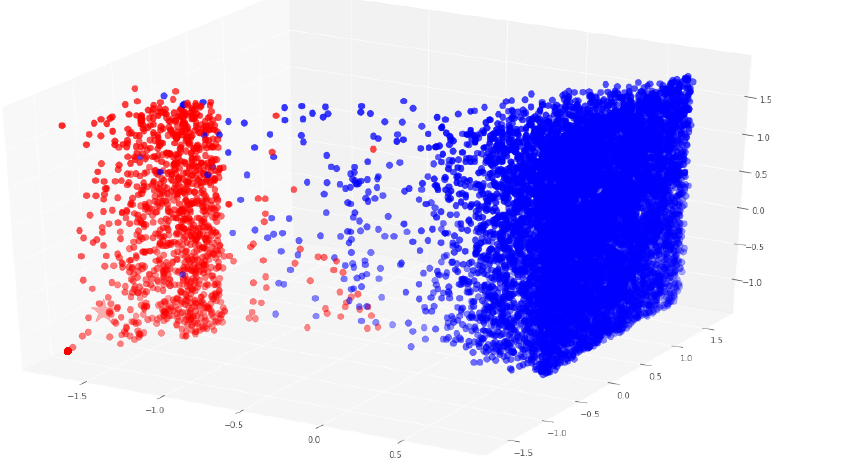
Figure 4. Clustering of dataset